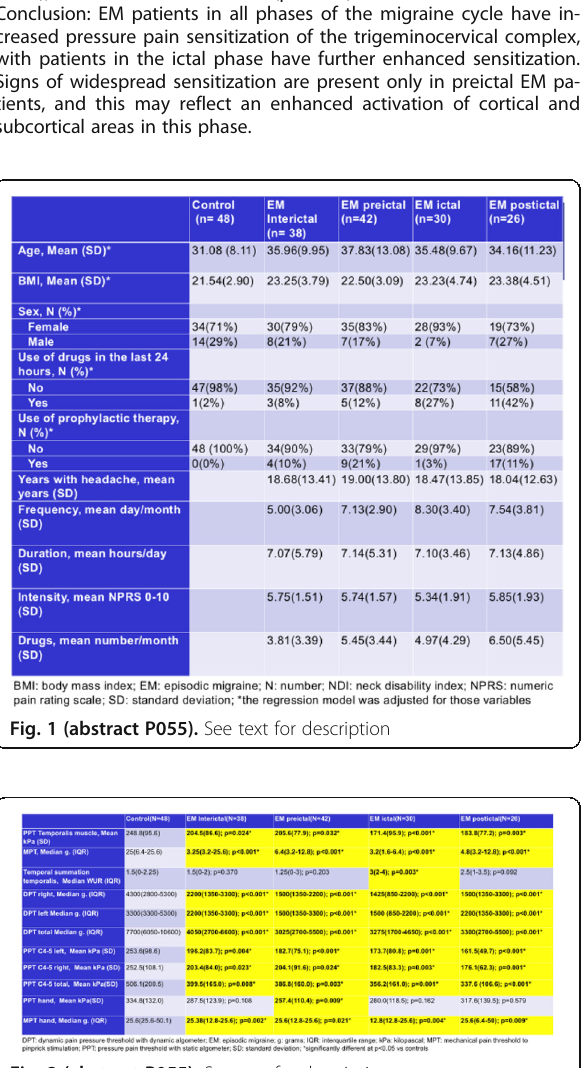
Fig. 2 (abstract P055). See text for